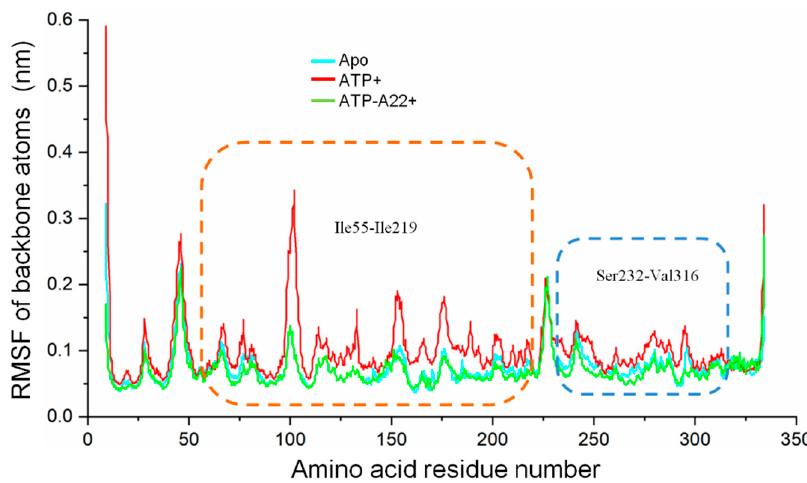
Figure 6. Root mean square fluctuations (RMSF) of the backbone atoms (N, CA, and C) of chain B of the apo, ATP+, and ATP-A22+ filaments. The cyan, red, and green curves represent RMSFs of chain B of the apo, ATP+, and ATP-A22+ filaments, respectively. Regions corresponding to the Ile55-Ile219 and Ser232-Val316 are indicated by the orange- and blue-dashed rectangles, respectively.